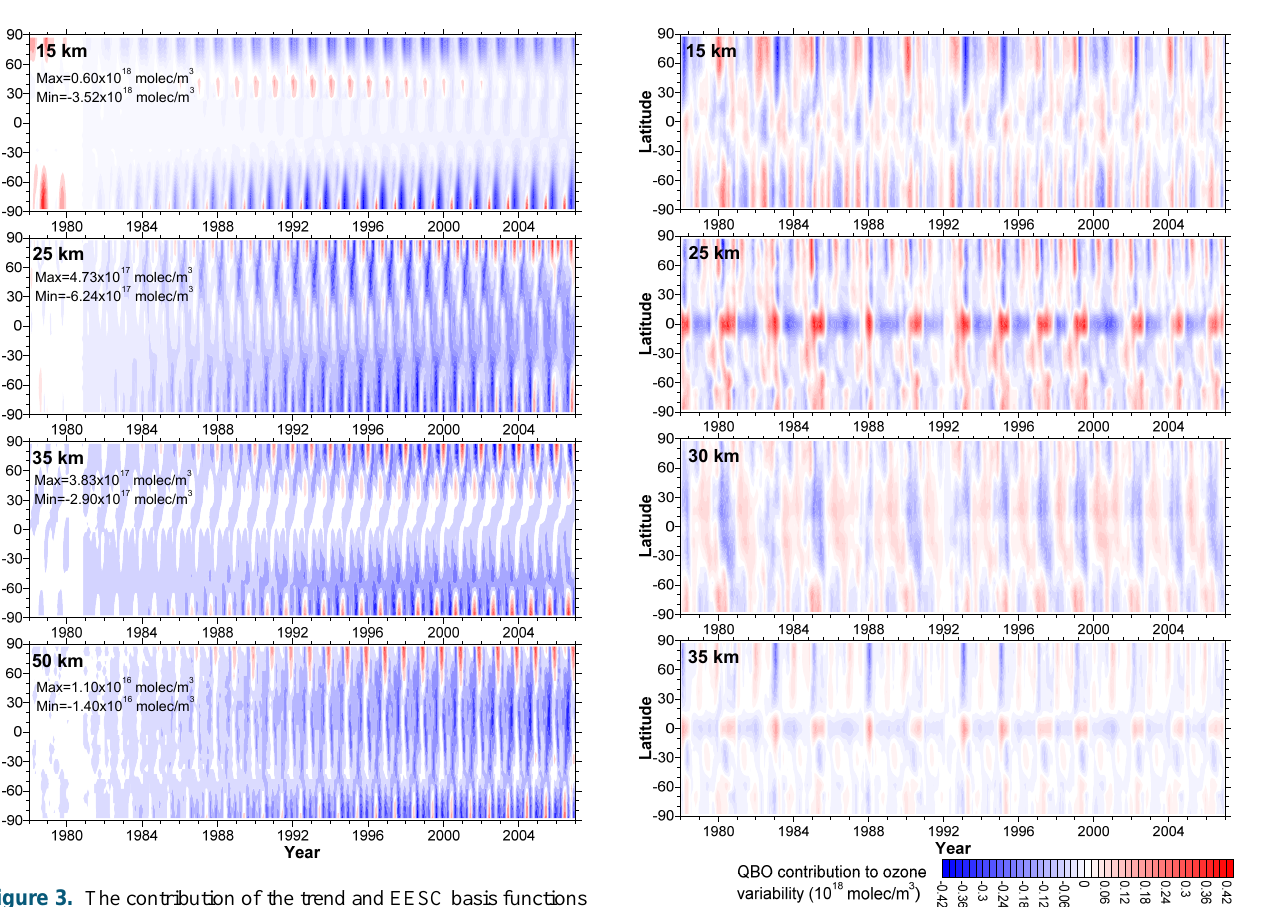
Figure 3. The contribution of the trend and EESC basis functions to ozone variability, relative to a 1980 baseline, at four indicative Figure 4. The contribution of summed QBO basis functions to Fig. 3. The contribution of the trend and EESC basis functions to ozone variability, relative to a 1980 baseline, levels, i.e., 15, 25, 35 and 50km. Red shows increases in ozone ozone variability, relative to a 1980 baseline, at four indicative lev- with respect to the 1980 baseline while blue shows decreases. The at 4 indicative levels i.e 15, 25, 35 and 50 km. Red shows increases in ozone with respect to the 1980 baseline Fig. 4. The contribution of summed QBO basis functions to ozone variability, relative to a 1980 baseline, at 4 els, i.e., 15, 25, 30 and 35km. Red regions show increases in ozone range of values is shown in each panel. while blue show decreases. The range of values is shown in each panel. with respect to the zero in the QBO basis function while blue re- indicative levels i.e 15, 25, 30 and 35 km. Red regions shows increases in ozone with respect to the zero in the gions show QBO basis function while blue regions show decreases.